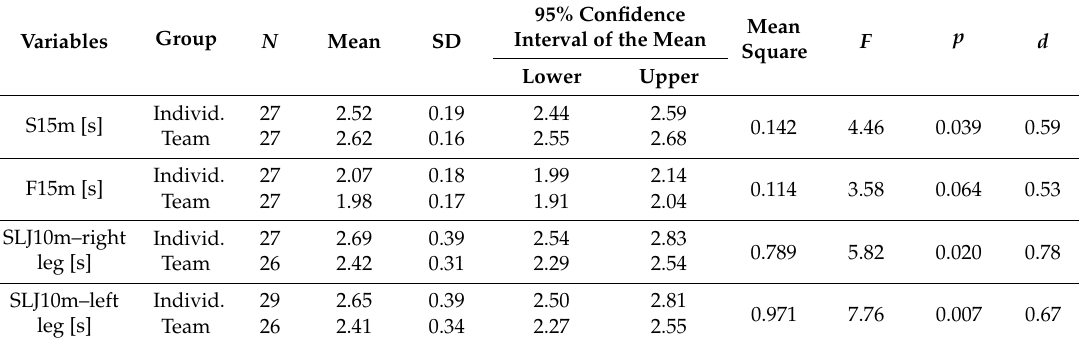
Table 3. Linear sprint speed and lower limb explosive power and between-group